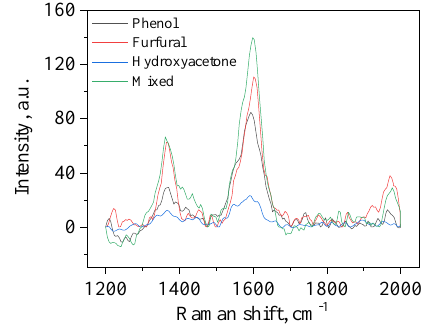
Figure 13. Ultraviolet-Raman (UV-Raman) spectra of the used catalysts.